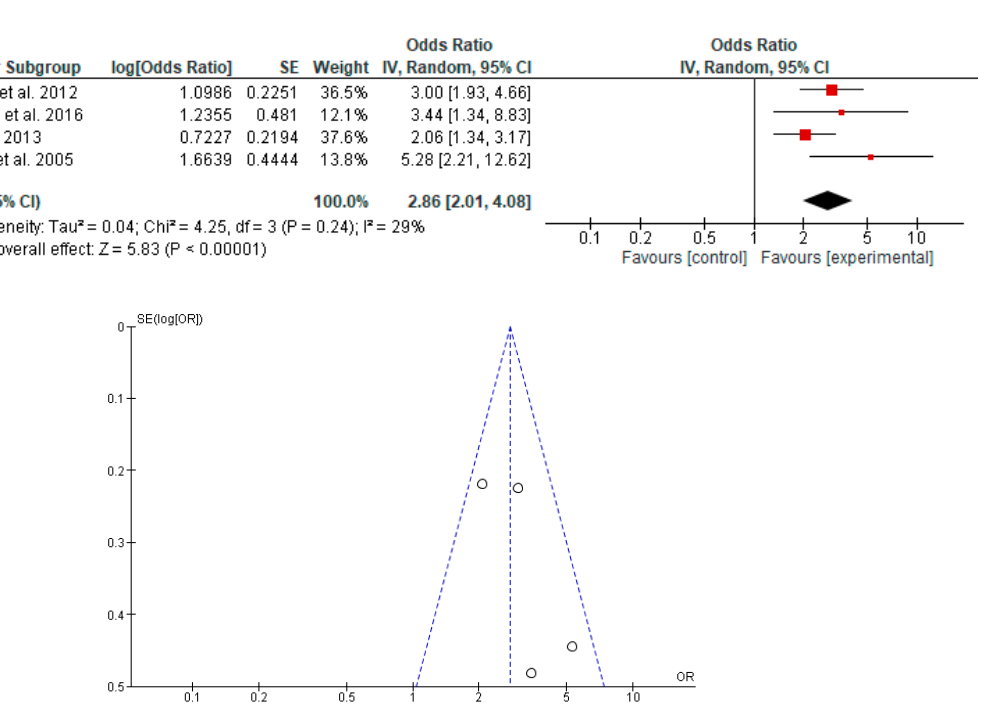
Figure 3. Forest plot and funnel plot of the association between the risk of LBW in new- borns with PD in pregnant women.